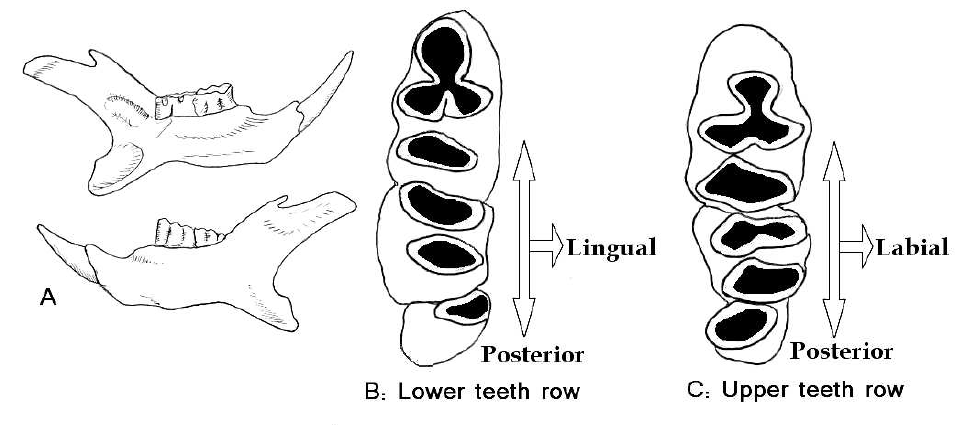
FIGURE 3 : Mandible B and C, Lower and upper tooth row in